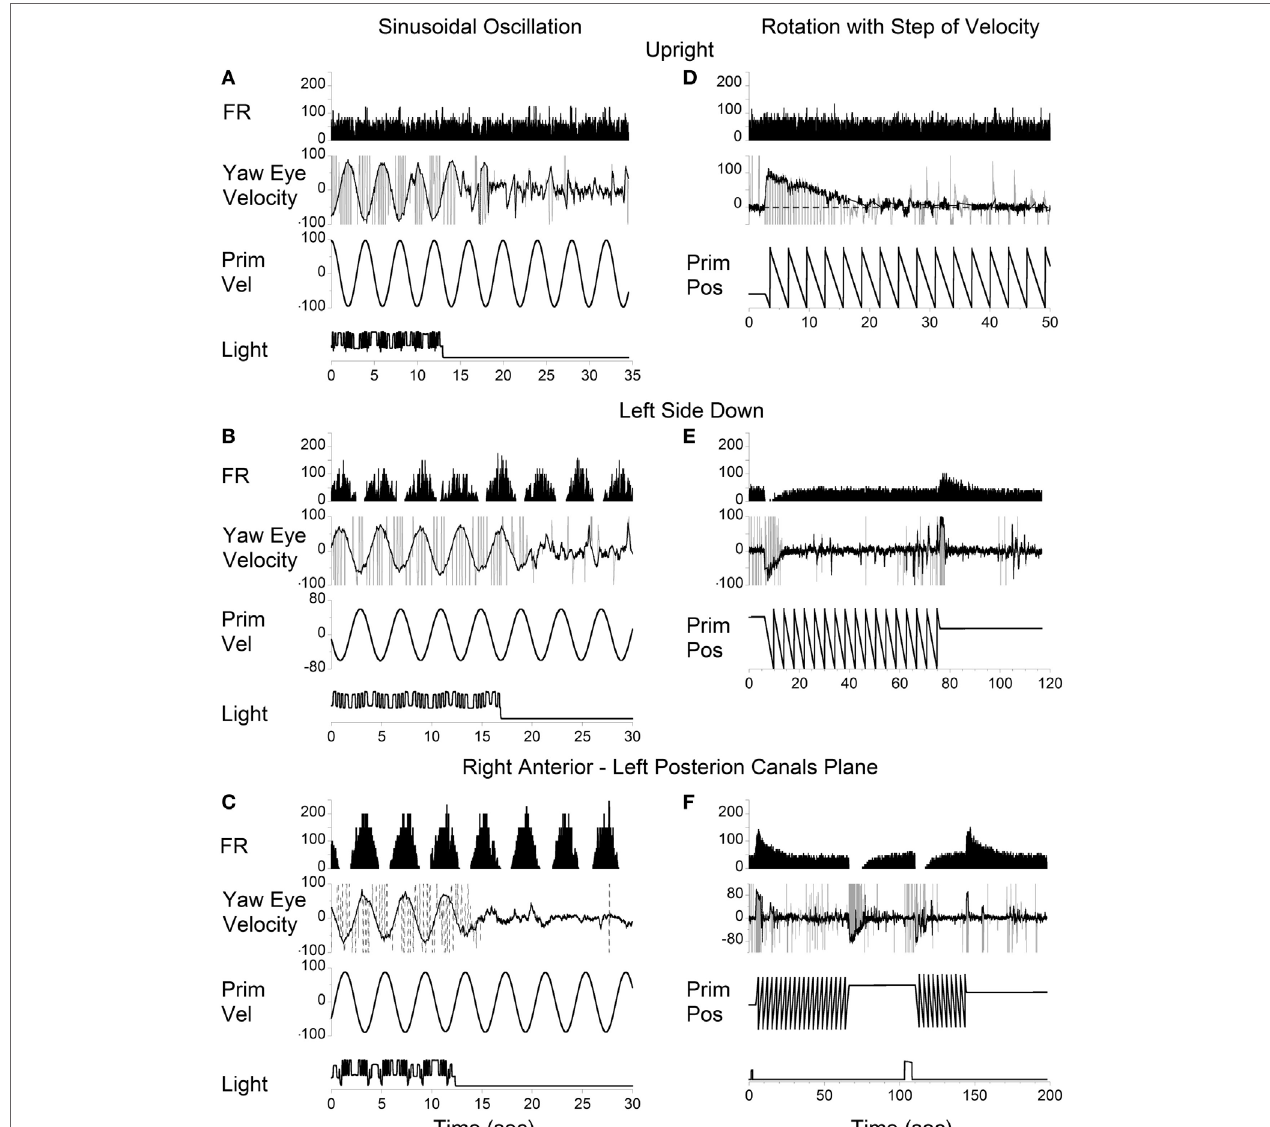
FigUre 7 | Left posterior canal-related neuron tested by sinusoidal oscillation (a–c) and by step rotation (D–F) about a spatial vertical axis while the animal was upright (a,D) , tilted left side down (B,e) , or tilted left side down and then rotated 90° counterclockwise in yaw to bring the right anterior–left posterior canals to the plane of rotation (c,F)